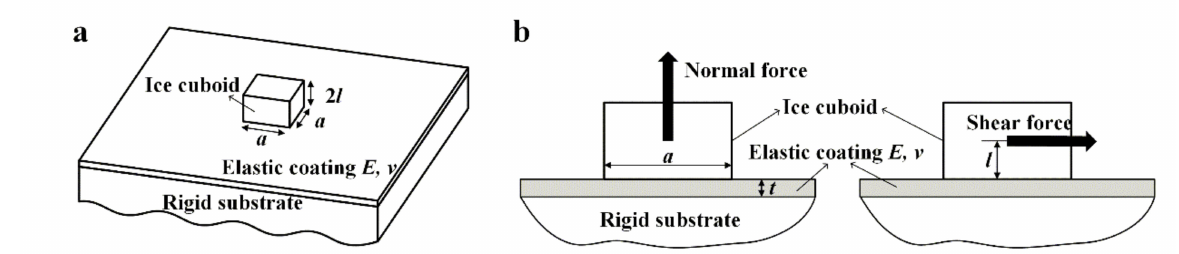
Figure 1. Schematics of ( a ) a rigid square-based ice cuboid adhered to an elastic coating that is bonded to a rigid substrate; ( b ) the ice cuboid under normal and shear loading. E : elastic modulus; v : Poisson’s ratio; l : the distance from the loading point to the cuboid-film interface; a : the size of the interface length.